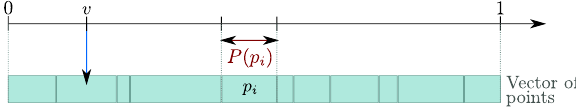
Figure 9: Illustration of the point selection with non uniform probability.